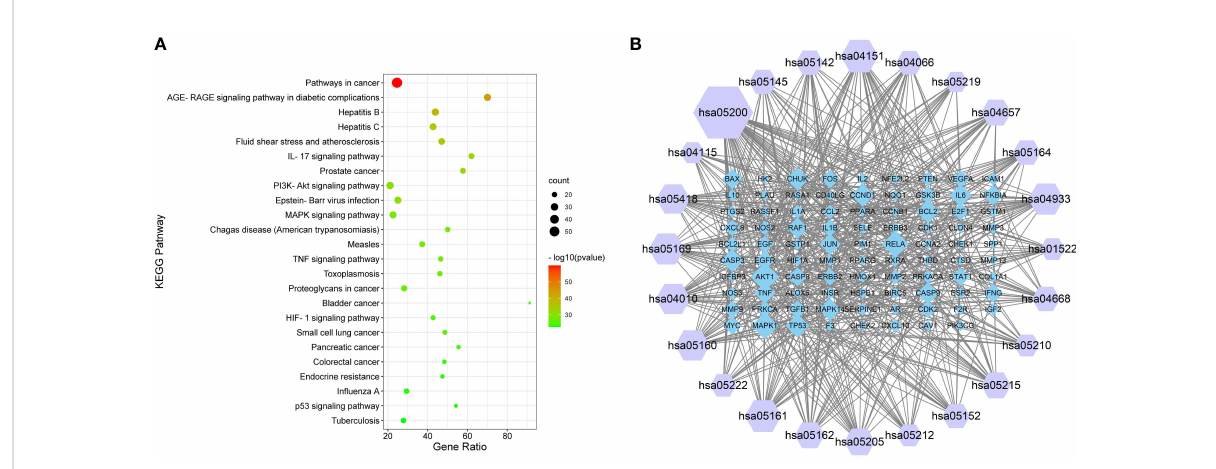
FIGURE 5 KEGG pathway enrichment analysis of GQZ in the treatment of NSCLC. (A) Pathway enrichment results at p<0.01. (B) Targeted pathway networks associated with the mechanism of action of GQZ in the treatment of NSCLC. Purple nodes represent paths, while blue nodes represent targets participating in these paths. Each edge represents the interaction between the target and the path, with node size being directly proportional to the degree of